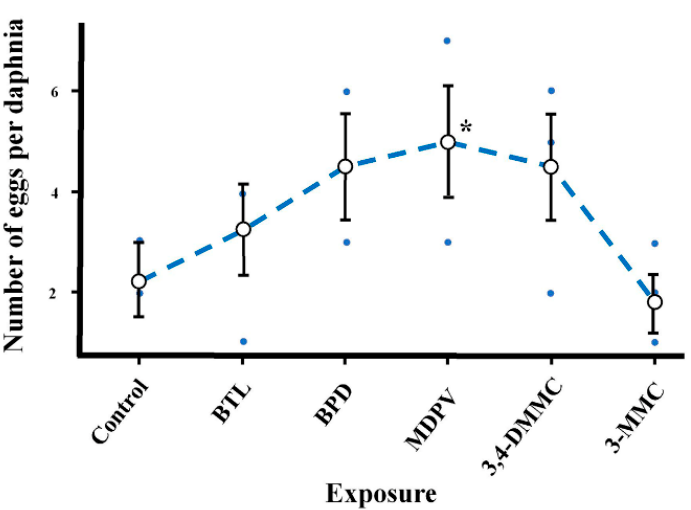
Figure 5. Reproductive effects (number of eggs per daphnia) on Daphnia magna at day 8 of exposure to BTL, 3,4-DMMC, 3-MMC, MDPV, and BPD. (Asterisks (*) represent significant differences compared to the control).